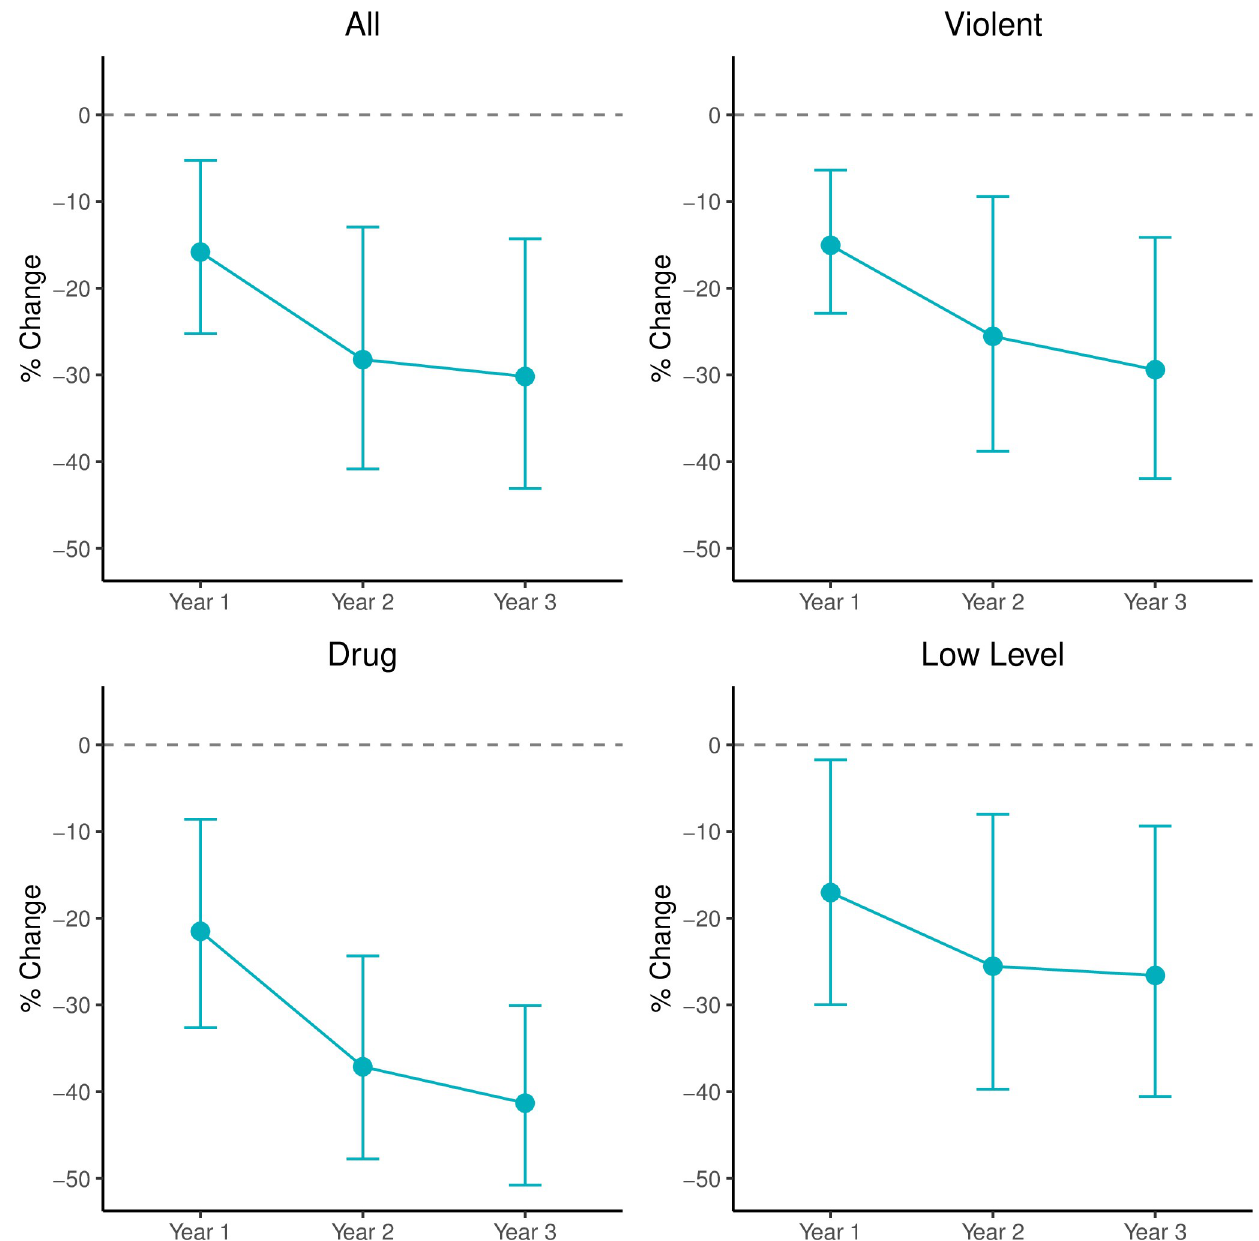
Fig 2. Estimated percentage change and 95% confidence intervals in arrest rates each year after Medicaid expansion, compared to non-expansion counties. Estimates from difference-in-differences models comparing changes in arrest rates each year after Medicaid expansion, compared to non- expansion counties. These models include county and state-level covariates as well as state and year fixed effects.